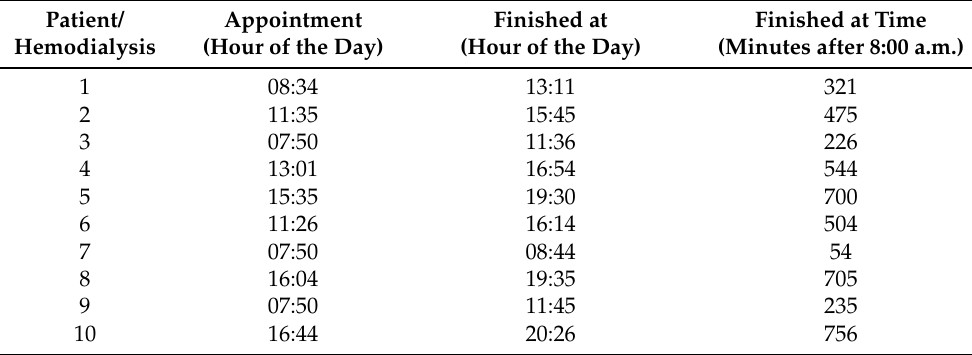
Table A7. Appointments and finalization time for